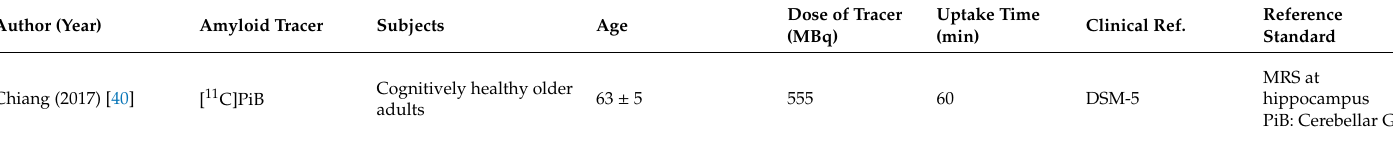
Table 1. Clinical utility of amyloid positron emission tomography (PET) scans in diagnosing Alzheimer’s disease